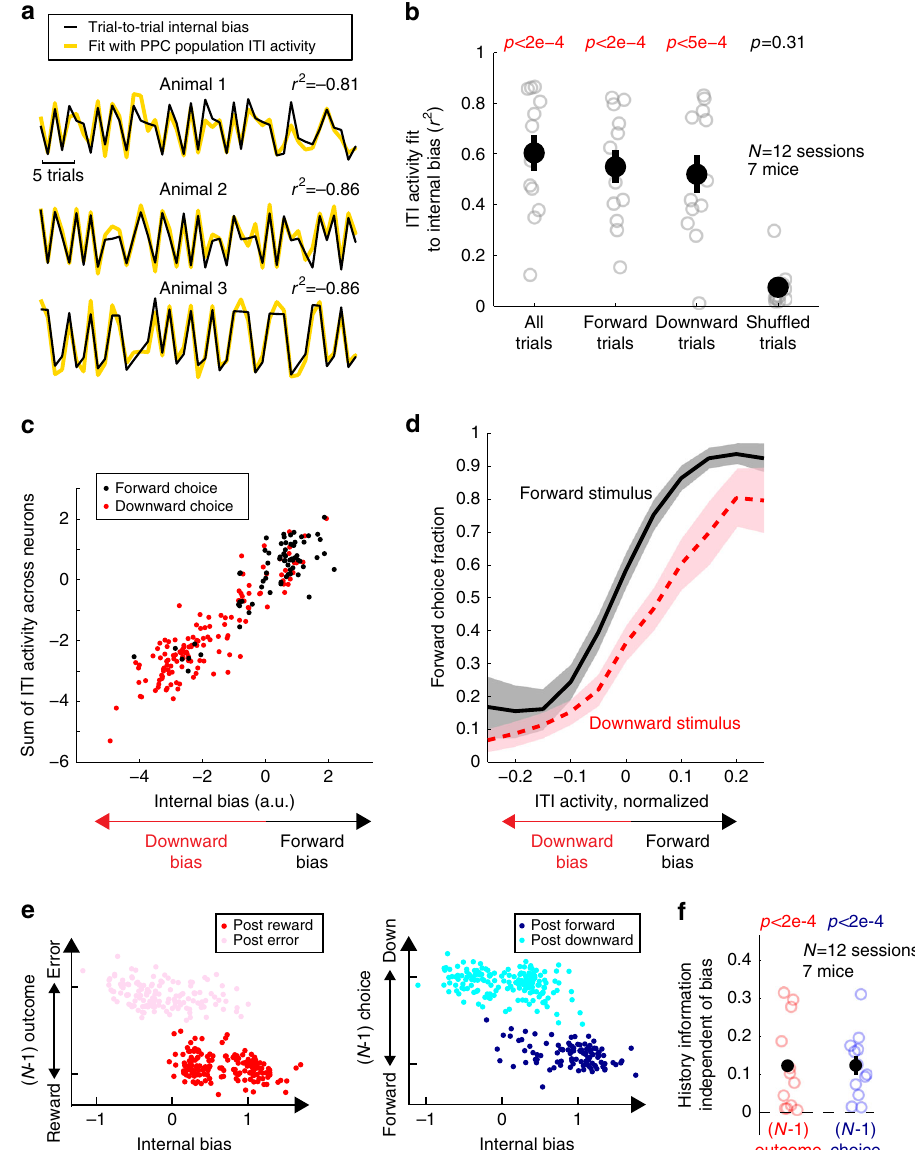
Fig. 6 Pre-stimulus population activity in PPC re fl ects the history-dependent bias and previous trial history. a Sequences of internal bias (thin black lines, estimated from the behavioral model) and weighted sum of ITI activity (thick yellow lines) across simultaneously imaged PPC neurons in three example mice. b Goodness of fi t of PPC ITI activity to the internal bias across (from left to right): all trials, only forward choice trials, only downward trials, and shuf fl ed trials. Only the sessions in which the history-dependent bias is signi fi cant (likelihood-ratio test between the full model and a partial model that contains only stimulus and constant terms, p < 0.05, 12 sessions; Experimental Procedures) are included. Black, mean ± s.e.m. across sessions; gray, individual sessions. Wilcoxon one-sided signed rank test. c Data from a single session showing the weighted sum of PPC ITI activity across simultaneously imaged neurons against the internal bias estimated from the behavioral model. Each dot represents a single trial. d Fraction of forward choice as a function of the internal bias estimated from the ITI activity (mean ± s.e.m. across 12 sessions). Black, forward stimulus trials; red, downward stimulus trials. The estimated internal bias in each session was normalized such that it represents the signed distance from the decision boundary (Methods section) that divides the forward and downward choice trials. e Example population ITI activity from one session projected on a two-dimensional plane. Left: x -axis, activity encoding internal bias (i.e., estimated internal bias from the population activity, as in a ), y -axis, activity encoding N − 1 trial outcome (i.e., estimated N − 1 trial outcome from the population activity), each dot, a single trial. Population activity in trials with similar internal bias still encodes N − 1 trial outcome information (reward or error). Right: x -axis same as the left and y -axis shows the activity encoding N − 1 trial choice. f History information independent of internal bias in the ITI activity, computed as (prediction accuracy of history information decoded from the ITI activity – prediction accuracy of history information decoded from the ITI activity projected to the internal bias axis). Each dot represents a single session in which the behavioral model predicts the choice sequence signi fi cantly ( p < 0.001). Black, mean ± s.e.m. across mice. Wilcoxon one-sided signed rank